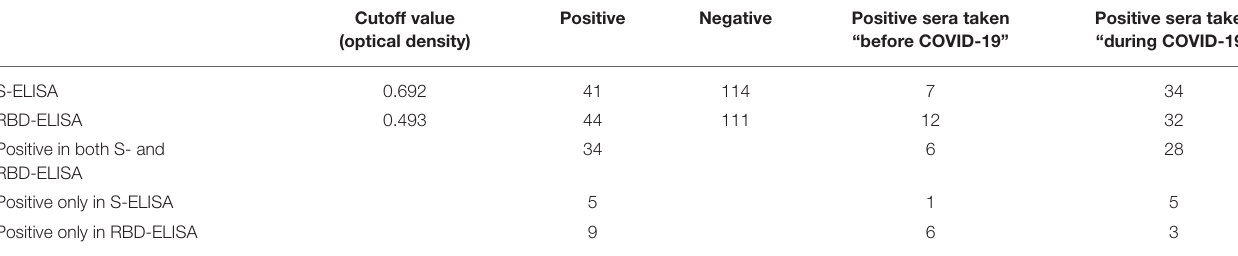
FIGURE 1 | OD values of cat sera collected “before COVID-19” and “during COVID-19” tested in the S- and RBD-ELISAs. The blue horizontal line (bottom line) indicates the “cut-off” value for the RBD-ELISA and the red horizontal line (upper line) indicates the “cut-off” value for the S-ELISA.